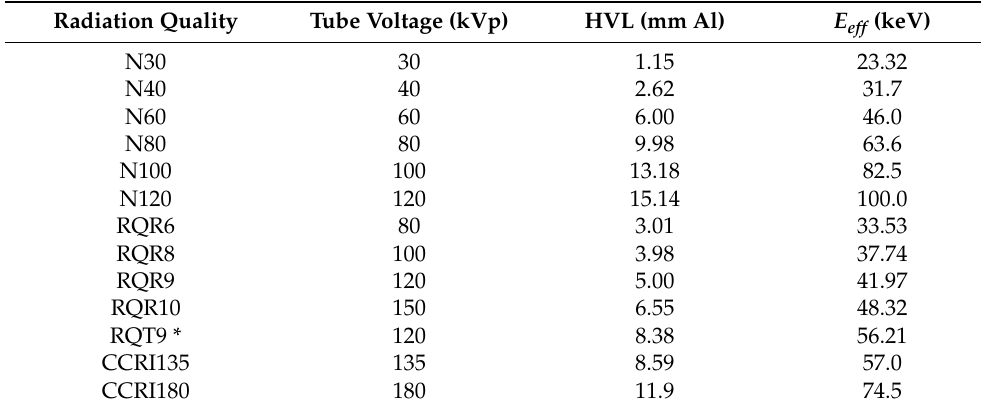
Table 1. LNHB radiation qualities used and corresponding tube voltage, HVL, and effective energy E ef f . * RQT9 is the reference radiation quality in CT